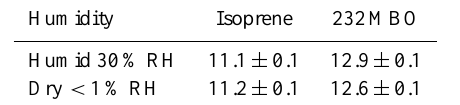
VOC + [cps]/NO + [cps]ppbv − 1 ) obtained for a drift pressure